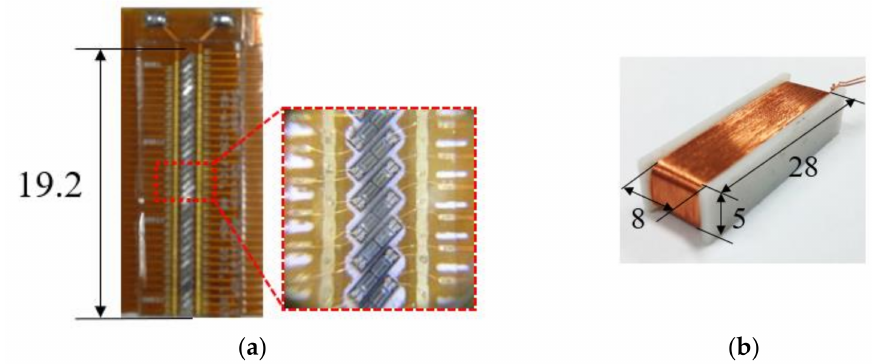
Figure 3. ( a ) Sensor array and ( b ) exciting coil (unit: mm).